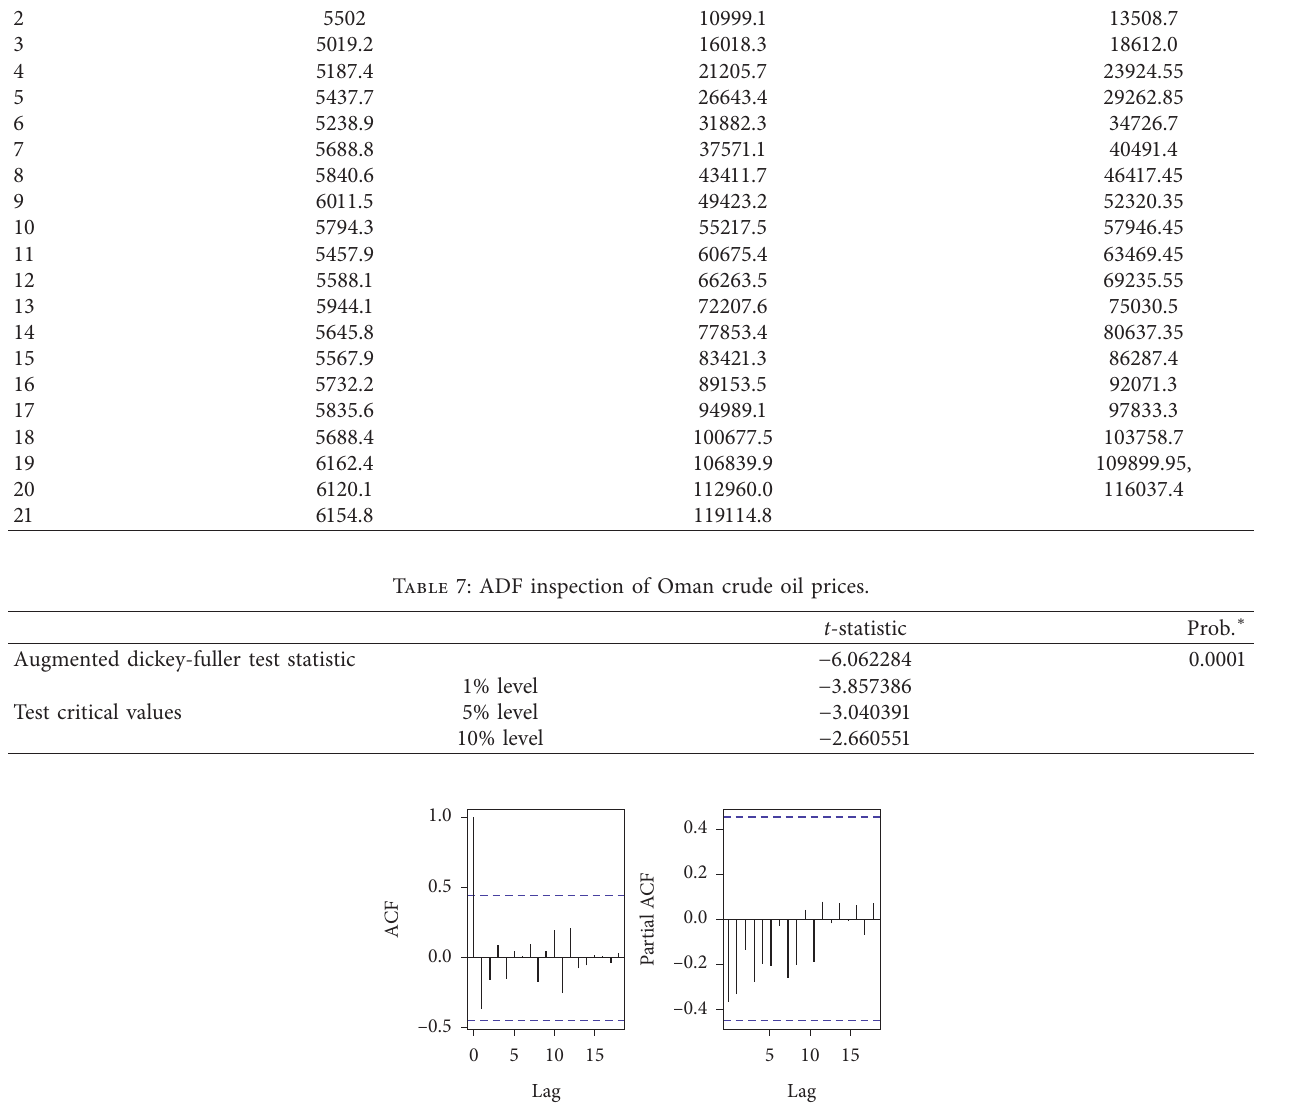
Figure 9: Autocorrelation graph and partial autocorrelation graph of Oman crude oil price difference series. Table 8: Index prediction value.